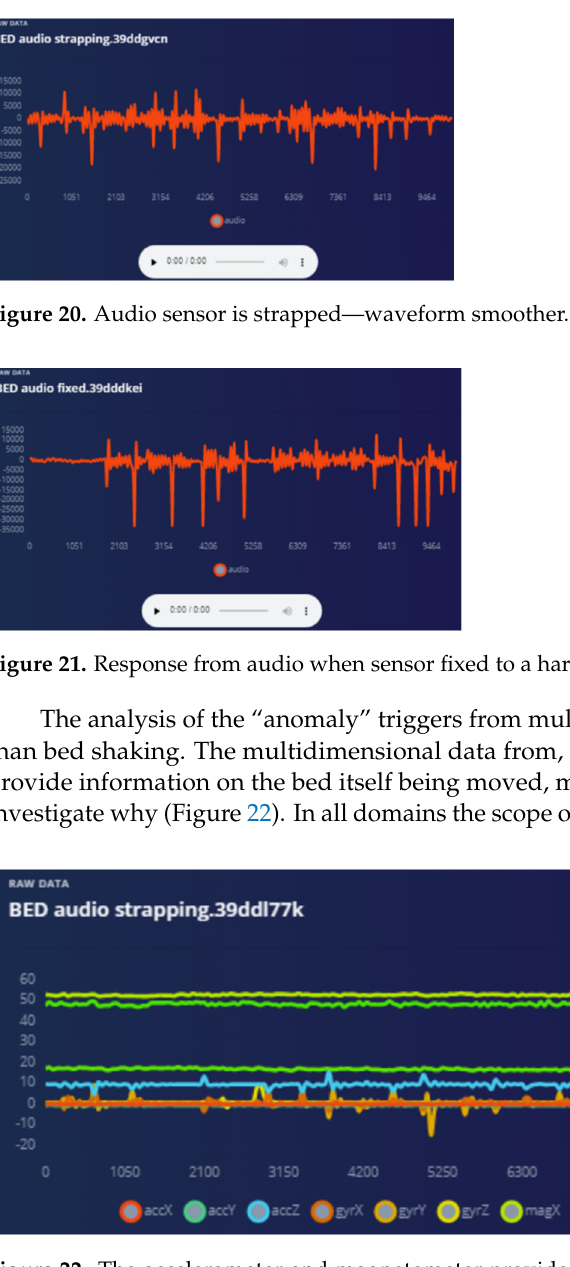
Figure 19. Bed vibrations with strapping suspended sensor.